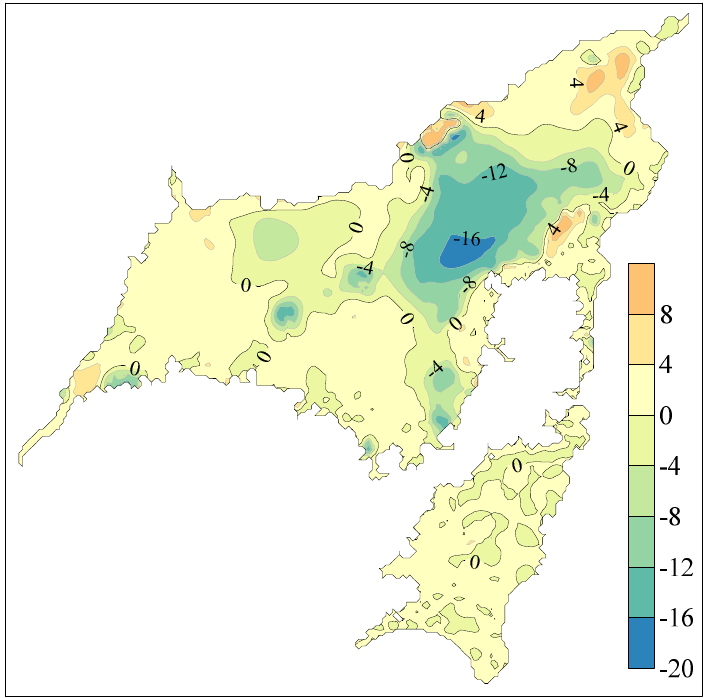
Figure 4. Variation of groundwater level from 2000 to 2014 in the plain areas. Negative values mean that the groundwater level drops (unit: m).